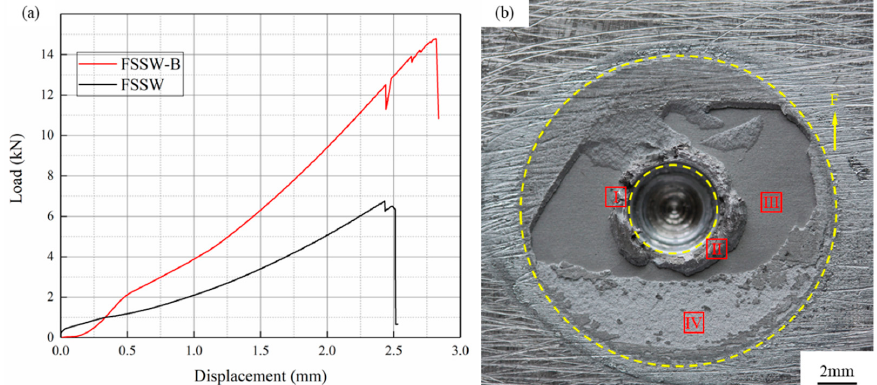
Figure 7. ( a ) Comparison of the lap shear fracture load of FSSW-B and FSSW joint at the same process parameter (1200 rpm); ( b ) macrograph of the fracture surface of FSSW-B joint (Ti6Al4V side). The yellow dotted lines in ( b ) mark the effective joining zone.